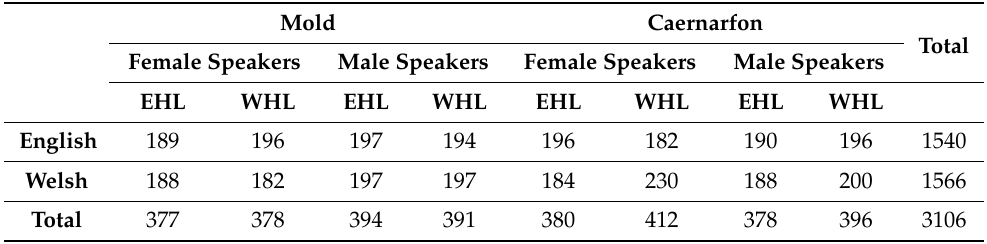
Table 2. Number of tokens included in the analysis of /r/ in prevocalic and intervocalic positions (EHL = English home language, WHL = Welsh home